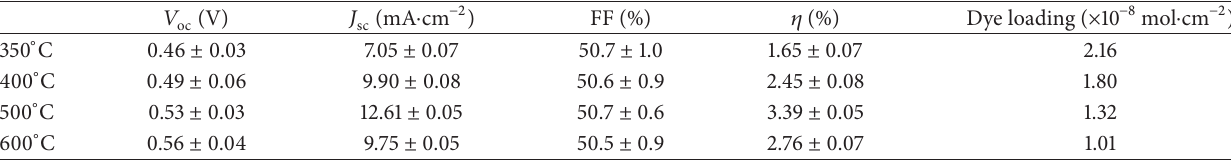
shell was annealed between 350 and 600 ∘ C a . 2